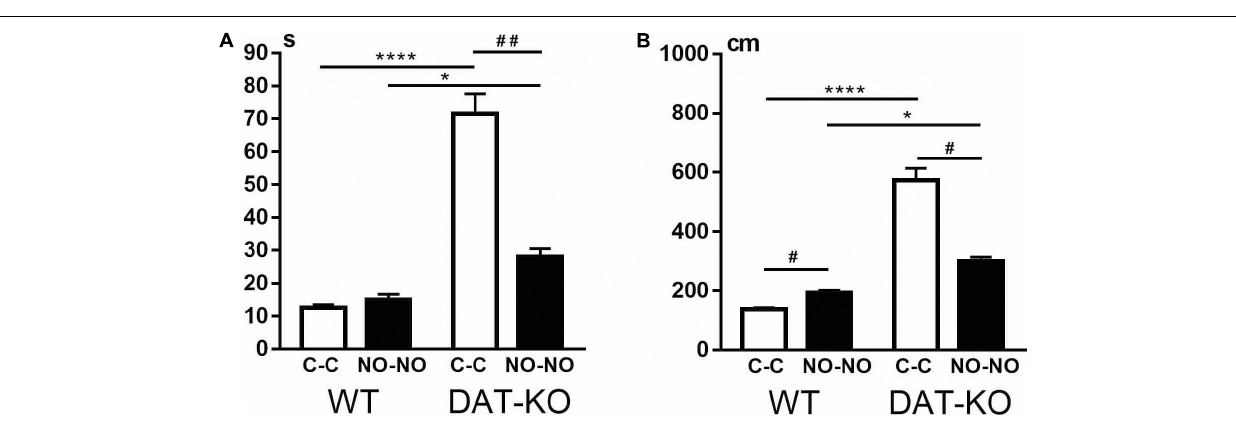
Frontiers in Behavioral Neuroscience |